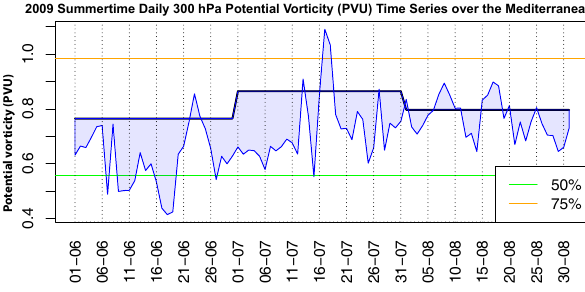
Figure 13. Same as Fig. 10 for the summer of 2009.